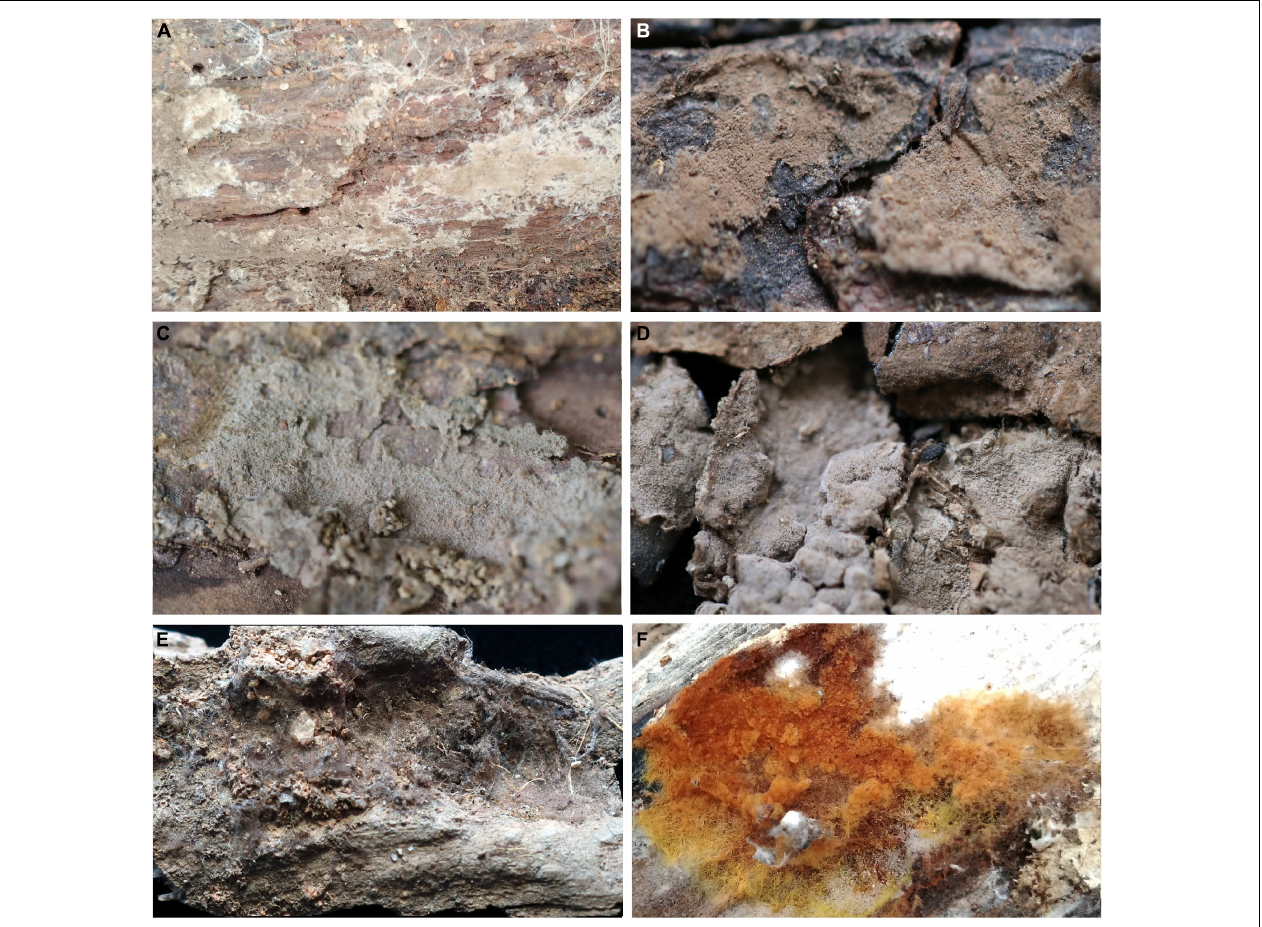
FIGURE 2 | Basidiocarps of Tomentella species. (A) T. bidoupensis (holotype Yuan 12707); (B) T. brevisterigmata (holotype Yuan 12700); (C) T. cinereobrunnea (holotype Yuan 12703); (D) T. longiechinula (holotype Yuan 12687); (E) T. stipitobasidia (holotype Yuan 12713); (F) T. verruculata (holotype Yuan 12684).